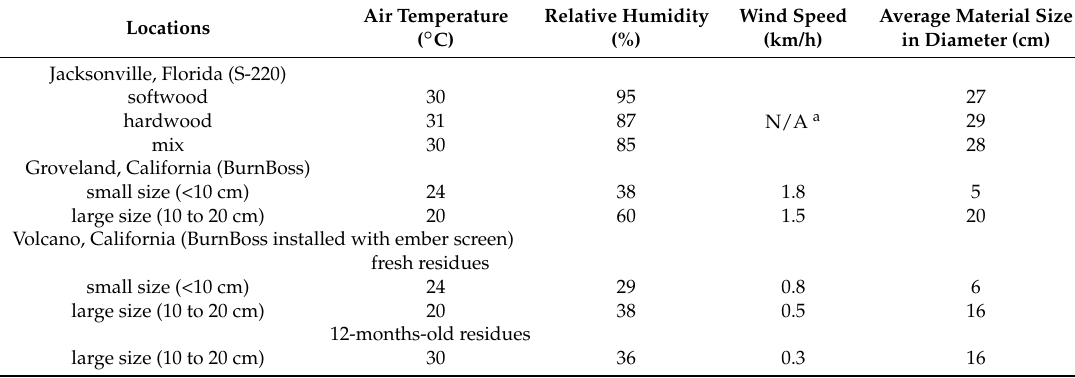
Air Temperature Relative Humidity Wind Speed Average Material Size ( ◦ C) (%) (km/h) in Diameter (cm)